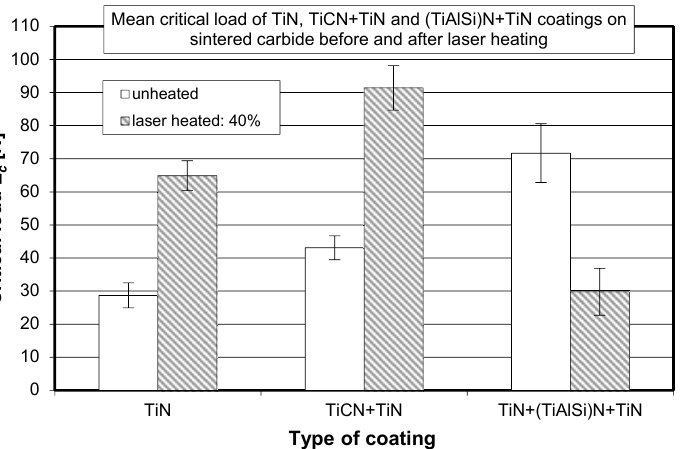
Figure 9. Effect of laser heating (with 40% of the maximum laser power) on the adhesion of single- layer (TiN), double-layer (TiCN + TiN), and triple-layer (TiN + (TiAlSi)N) + TiN) coatings to the replaceable cutting insert made of SM25 sintered carbide.